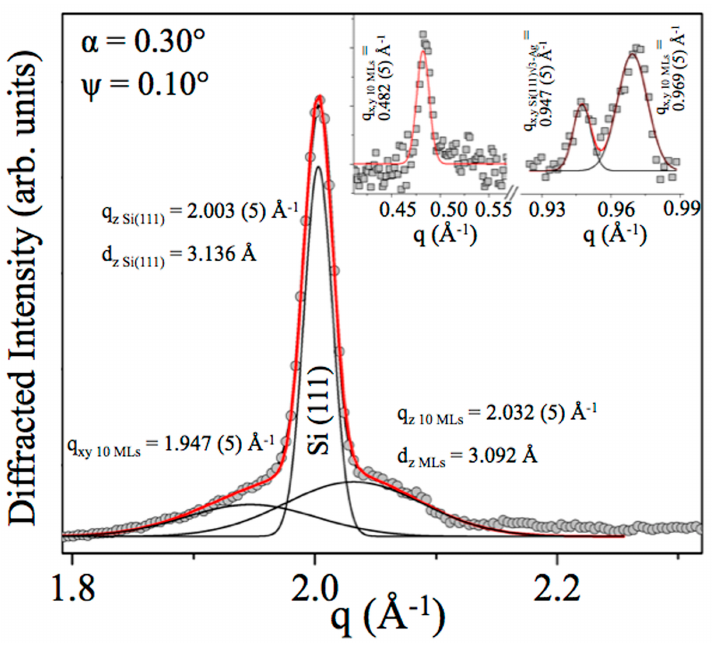
Figure 4. Energy dispersive GIXRD patterns from 10 MLs √ 3 × √ 3 Si film grown on reconstructed Si(111) √ 3-Ag: out-of-plane diffraction peaks located at q z Si(111) = 2.003 (5) Å -1 and q z 10 MLs = 2.032 (5) Å -1 with their Gaussian fits (black line) and in-plane second order reflection q xy 10 MLs = 1.947 (5) Å -1 . Peaks positions are the centroid of the Gaussians, and the full width at half maximum are: FWHM Si(111) = 0.020 Å - 1 , FWHM 10 MLs = 0.120 Å -1 and FWHM xy 10 MLs = 0.110 Å -1 . Right inset is representative of the